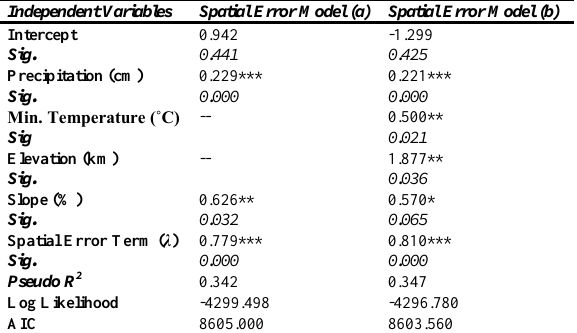
stock and the minimum value by the range of raw SOC stock.